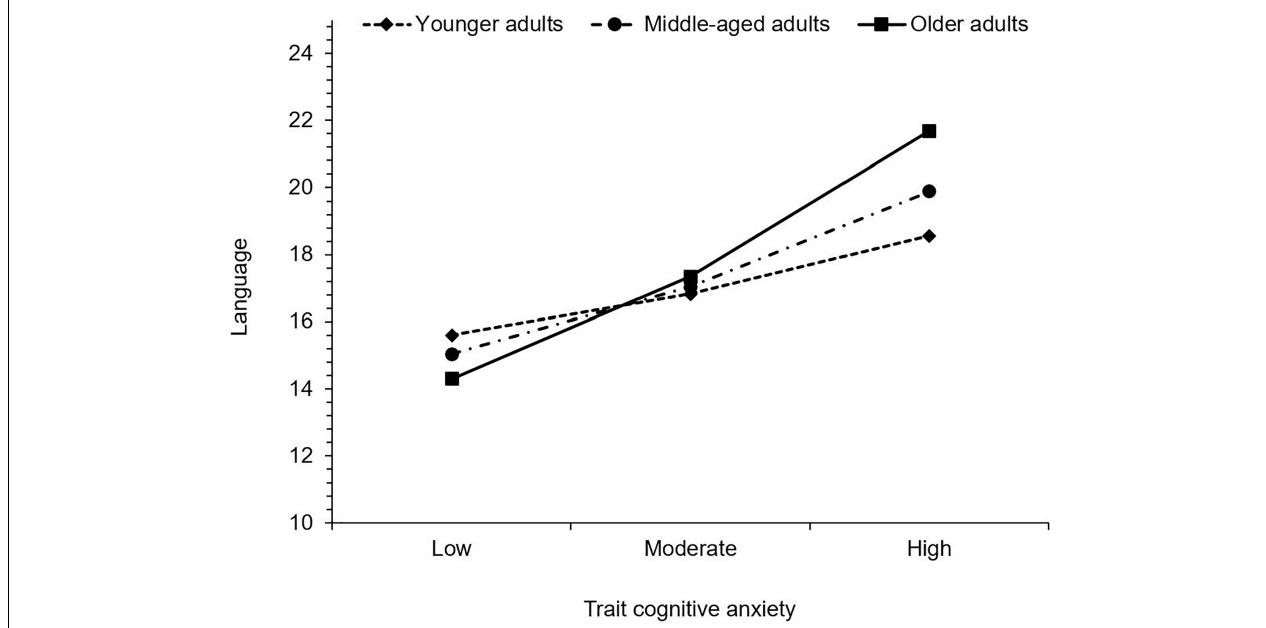
FIGURE 3 | Simple slopes illustrating the significant interaction between trait cognitive anxiety and age on language. Higher values indicate greater levels of subjective cognitive difficulty.